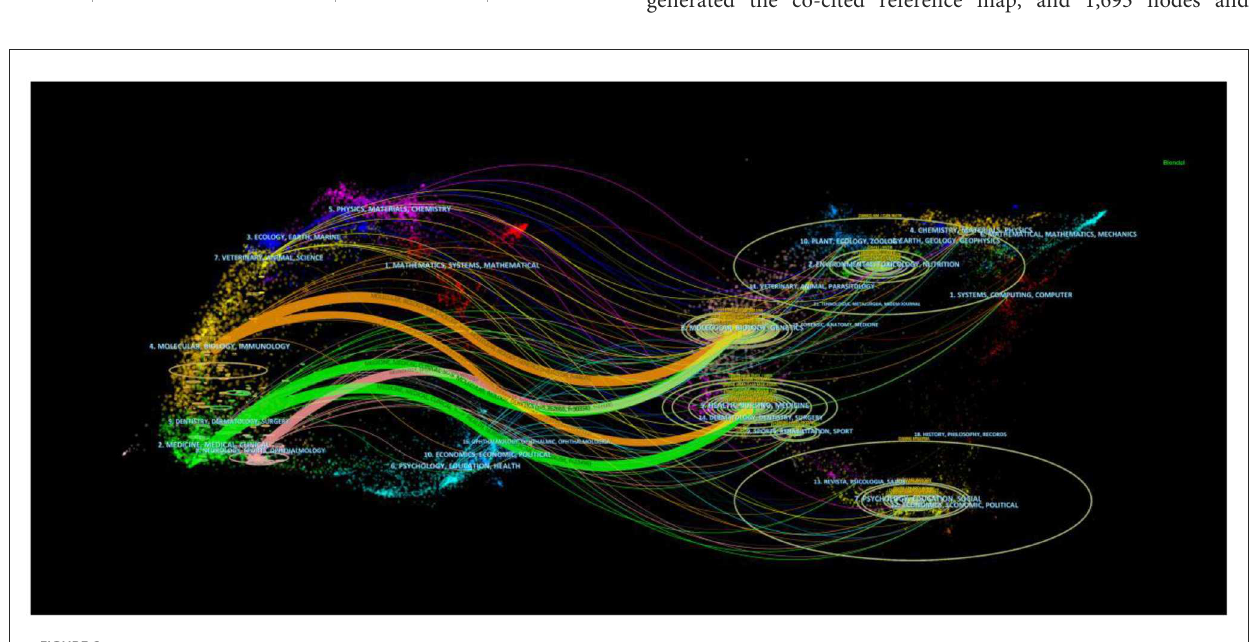
FIGURE6 Dual-map overlay of academic journals from 2002 to